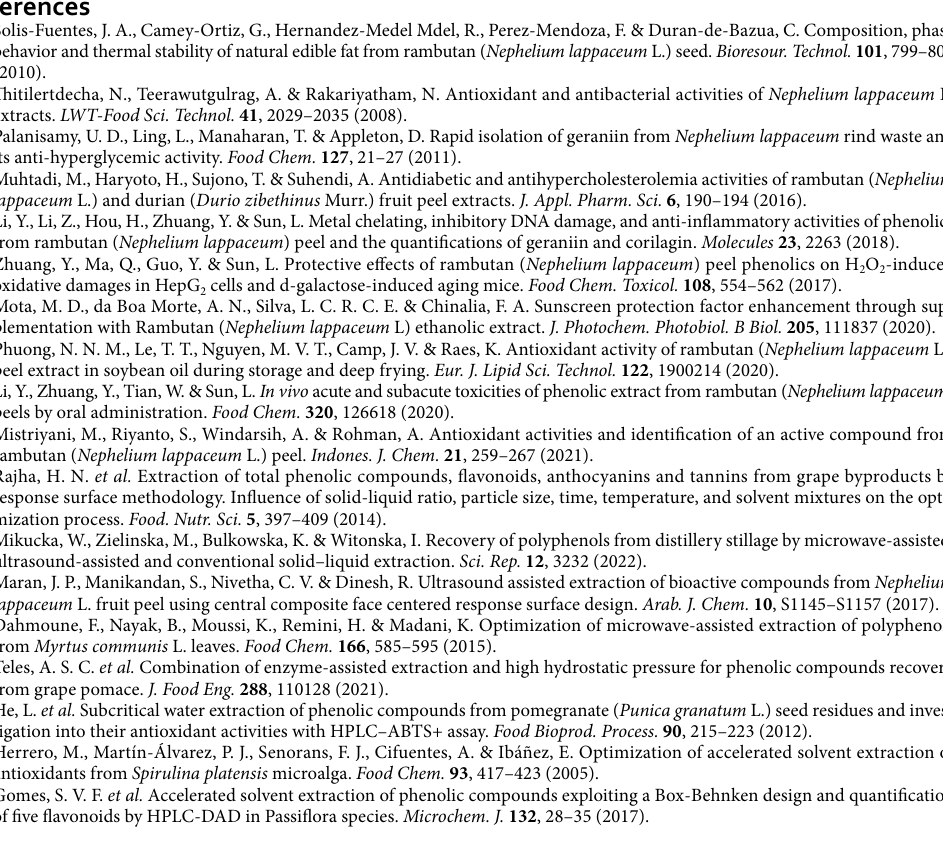
concentration of 54 vol% provided maximum total phenolic and total anthocyanin contents, with highest ABTS scavenging activity and satisfactory extraction yield. Geraniin, ellagic acid, shikimic acid and corilagin were identified as the important active compounds found in this extract. Rambutan peel crude extract retarded lipid oxidation even at low concentration (50 mg/kg) and showed promise as a source of compounds with potential applications as natural antioxidants. The application of rambutan peel extract in real food systems is worthy for further study.